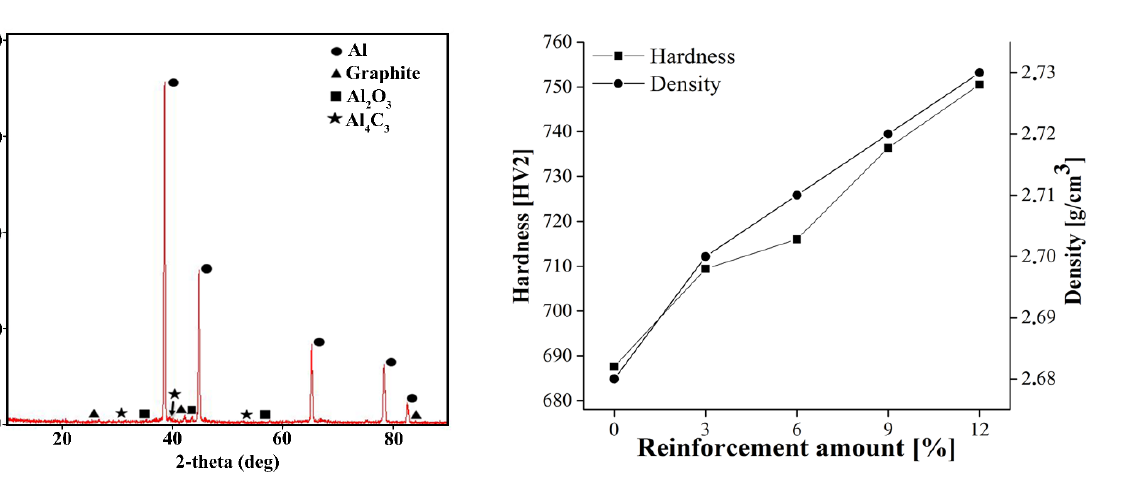
Figure 2: XRD result of the composite material produced with 12% Al 2 O 3 reinforcement.